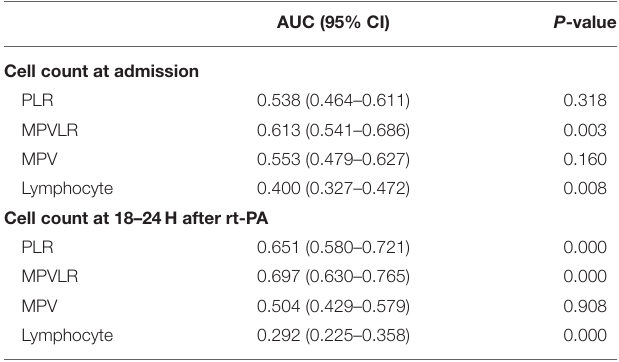
TABLE 3 | Comparison of the baseline characteristics between subgroups based on the MPVLR cutoff at admission.